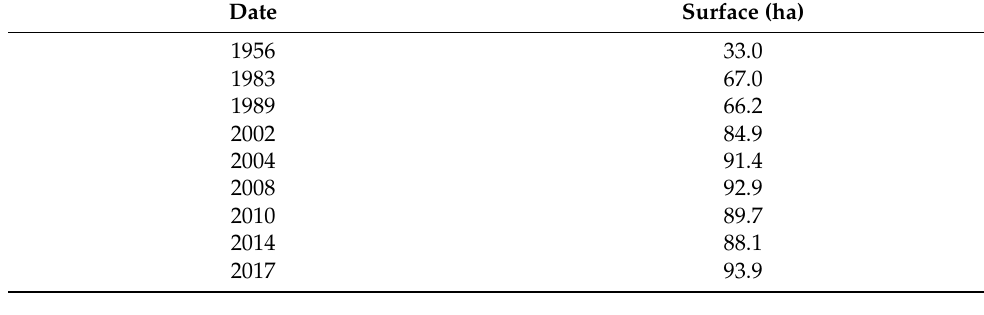
Table 4. Vegetation surface (ha) in each analyzed image.